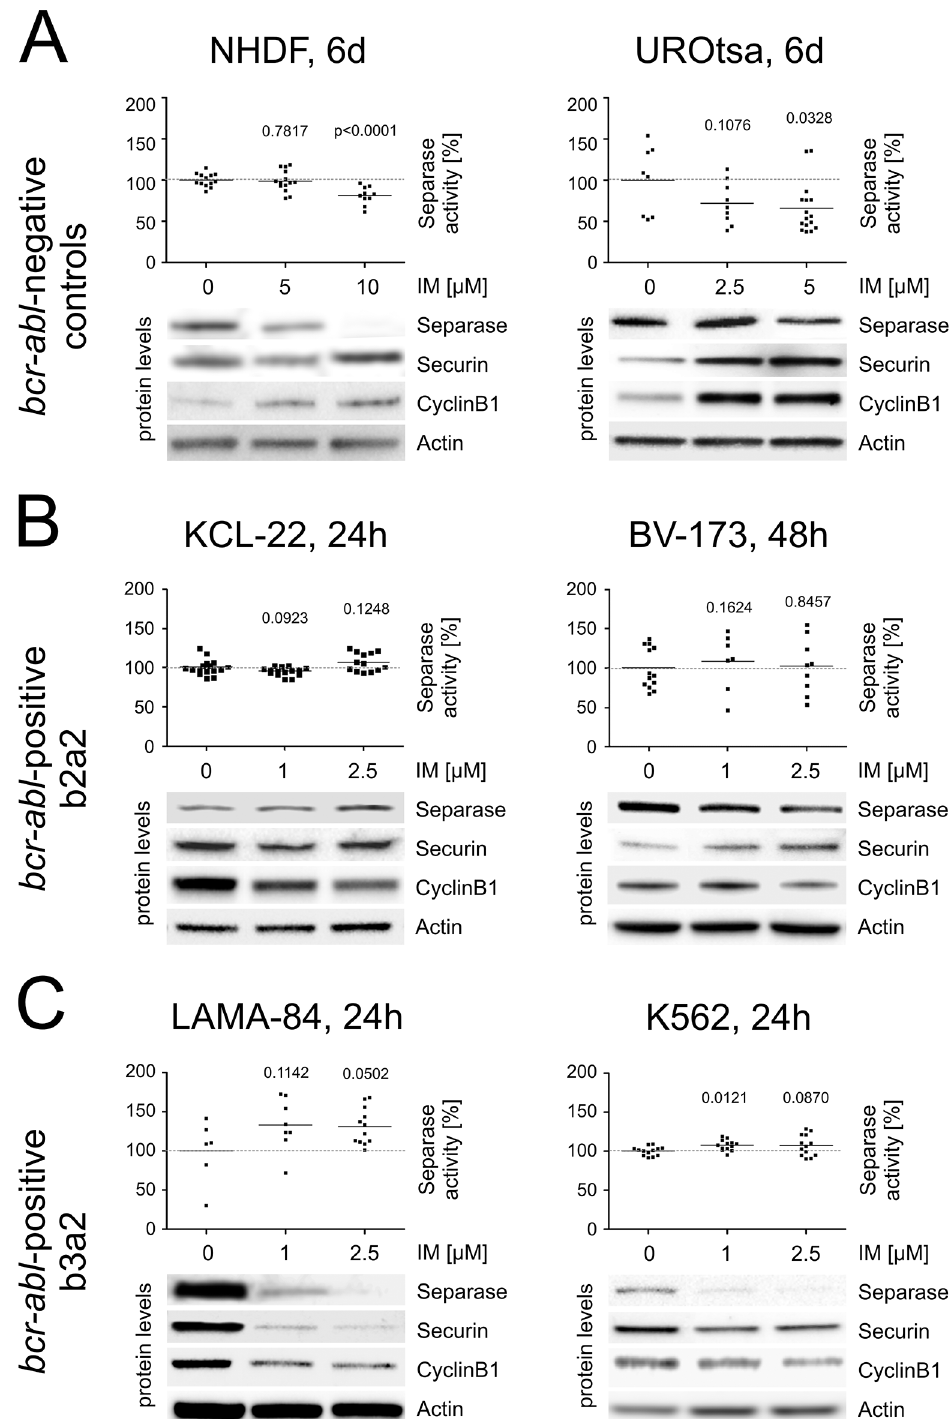
Fig 2. Separase proteolytic activity and levels of master Separase proteolytic activity regulators in bcr-abl -negative (A) and – positive cell lines (B, C) treated with IM. Cells were treated with IM for times and doses [ μ M] given on top. Separase proteolytic activity was quantified using an in vitro fluorometric assay and was given as relative fluorescence units/Actin (RFU/Actin). Analyses were performed on protein lysates derived from bcr-abl -negative ( A ) control cells (NHDF, UROtsa) and from p210BCR-ABL-positive cells with the bcr-abl breakpoint variant b2a2 ( B ) (KCL-22, BV-173) and variant b3a2 ( C ) (LAMA-84, K562). Each